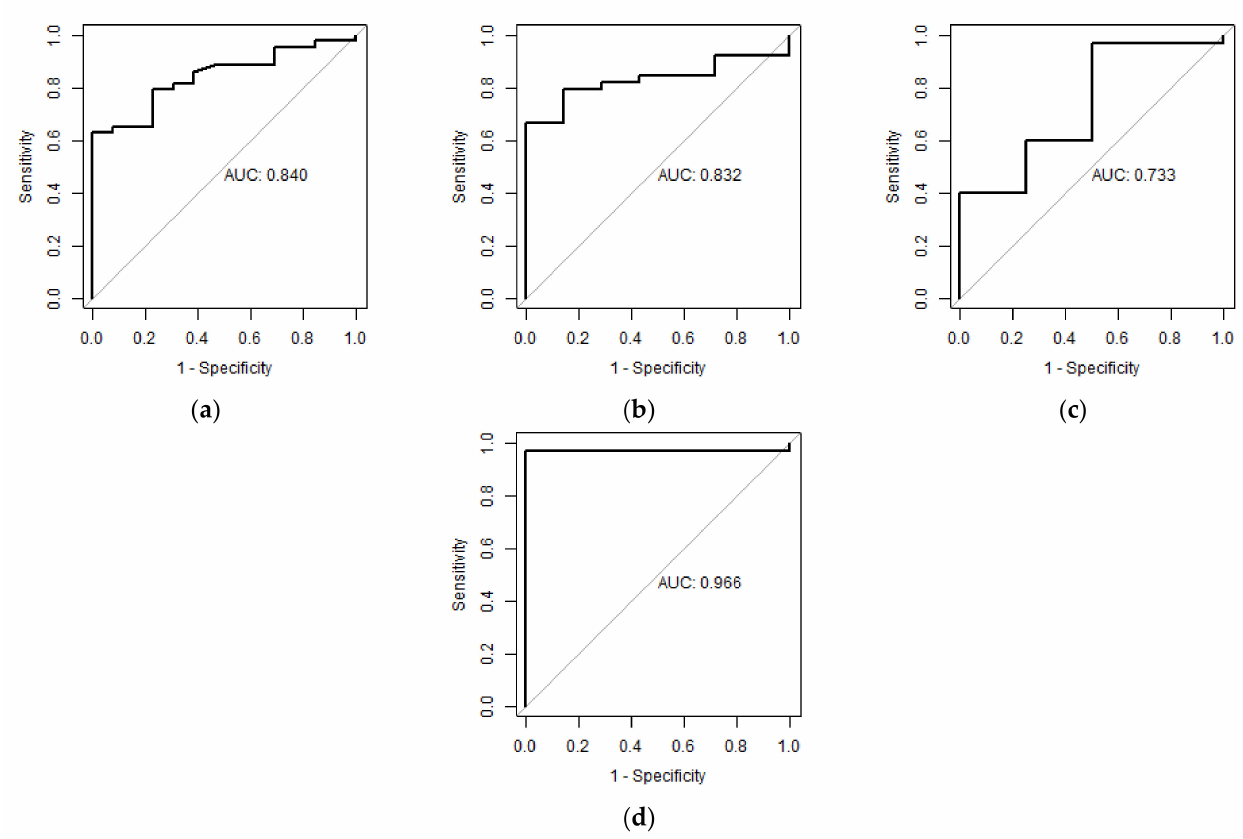
Figure 3. ROC curves showing sensitivity and specificity of TNF- α measurements for good functional outcome: ( a ) TNF- α < 4.5 h; after three months (cut-off point ≤ 39.94 pg/mL, sensitivity 62.8%, specificity 100%), ( b ) TNF- α < 4.5 h; after a year (cut-off point ≤ 42.54 pg/mL, sensitivity 62.8%, specificity 100%), ( c ) TNF- α within 24 h; after three months (cut-off point ≤ 60.14 pg/mL, sensitivity 96.7%, specificity 50.0%), ( d ) TNF- α within 24 h; after a year (cut-off point ≤ 60.14 pg/mL, sensitivity 60.1%, specificity